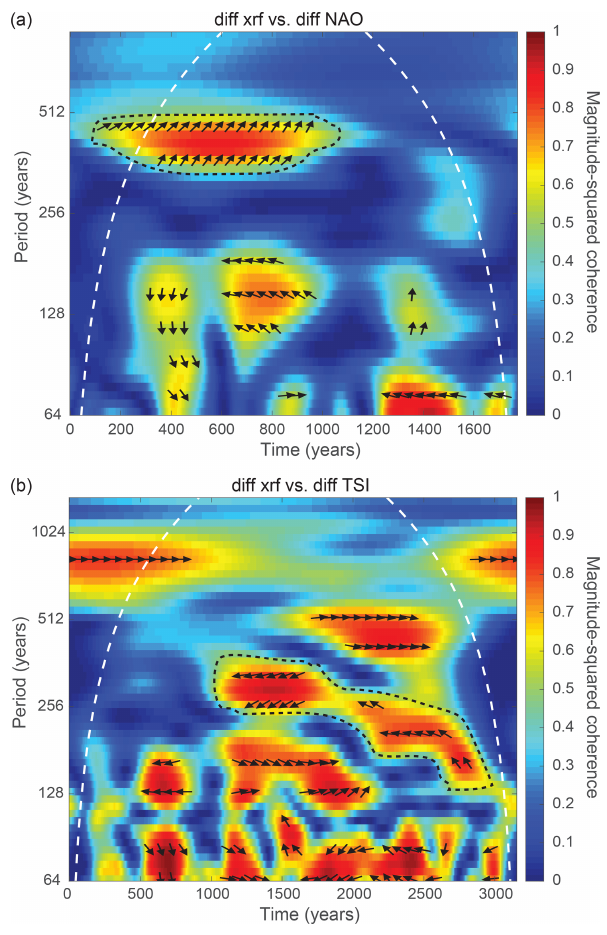
Figure 6. Cross-wavelet analyses for dust input versus NAO (a) and TSI (b) . The dotted line represents an identified significant cycle for each signal in single wavelet analyses (Fig. 5). Right and left arrows are respectively in phase or in phase opposition, and up and down arrows respectively show the first or second signal that predates the other one.